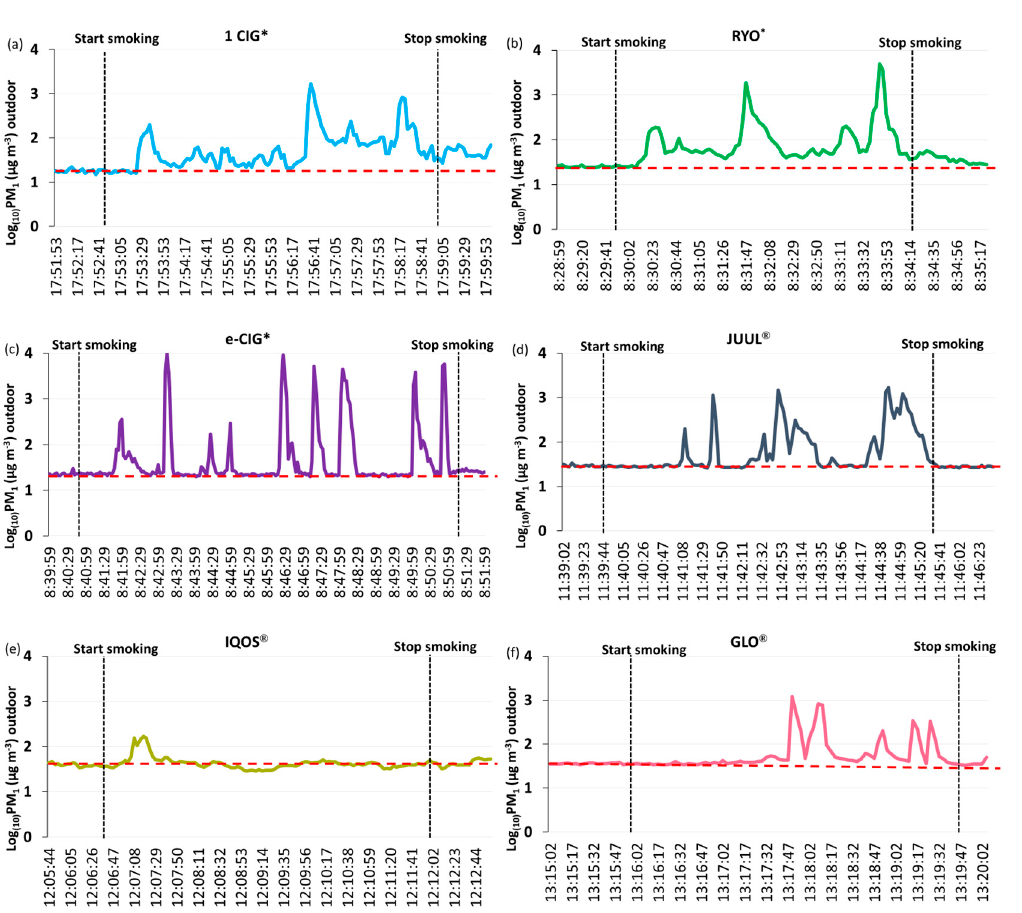
Figure 5. Outdoor PM 1 levels (expressed in Log (10) PM 1 ), measured point by point, for each device during a smoking/vaping session. Red dropped lines represent the arithmetic mean of outdoor Log (10) PM 1 , before starting smoking each device. * 1 cig = one conventional cigarette; RYO = “Rolled your own” hand-rolled cigarette; e-cig = electronic cigarette.